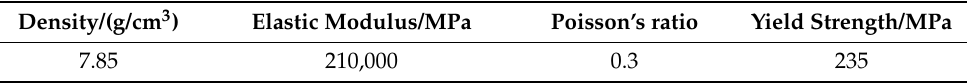
Figure 11. U-shaped ring finite element model.